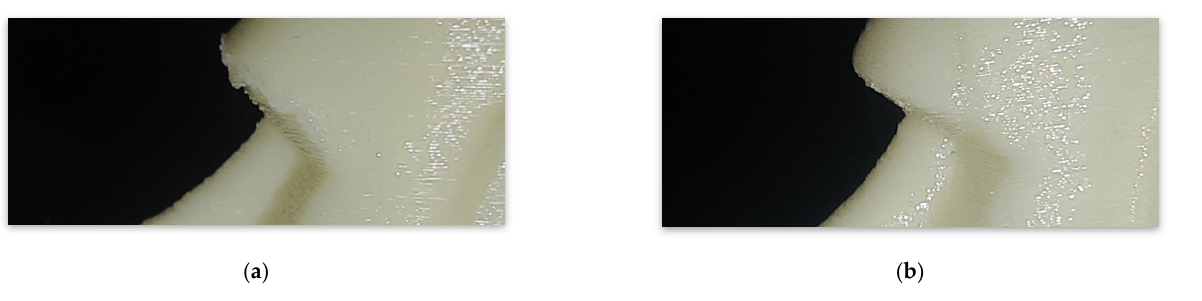
Figure 16. Comparison of as-fabricated surfaces: ( a ) Using conventional slicing software; ( b ) Using in-house slicer with the proposed algorithm.